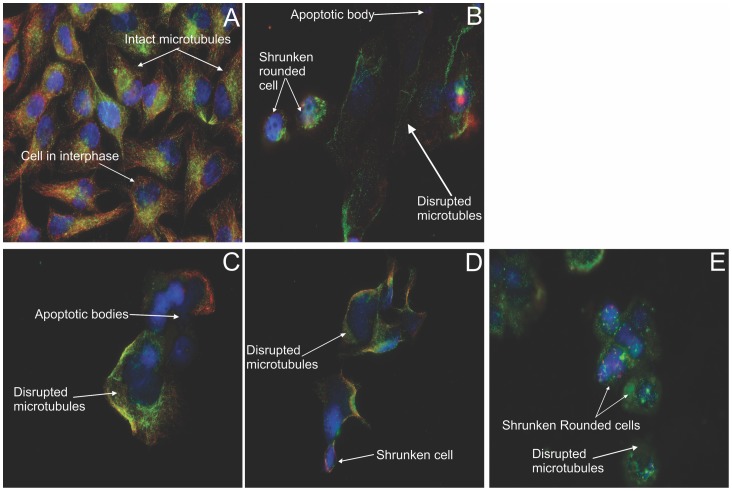
Immunofluorescent determination of microtubule dynamics in MDA-MB-231 cells.Double immunoflourecence was done to determine the compounds' effect after 24 h on microtubule dynamics within MDA-MB-231 cells. Tyrosinated (dynamic) microtubules are visualized as red, whereas the detyrosinated microtubules are stained green. The vehicle-treated cells (A) demonstrated an intact dynamic microtubule structure. The colchicine-exposed positive control cells (B) showed complete microtubule depolymerisation with few detyrosinated microtubule fragments remaining. ESE-16 (C), ESE-15-one (D) and EMBS-treated cells (E) demonstrated detyrosinated microtubule fragments. All treated cell samples demonstrated a decrease in cell density with rounded, shrunken cells. Apoptotic bodies are evident in the ESE-16 treated cells (X63 oil objective).